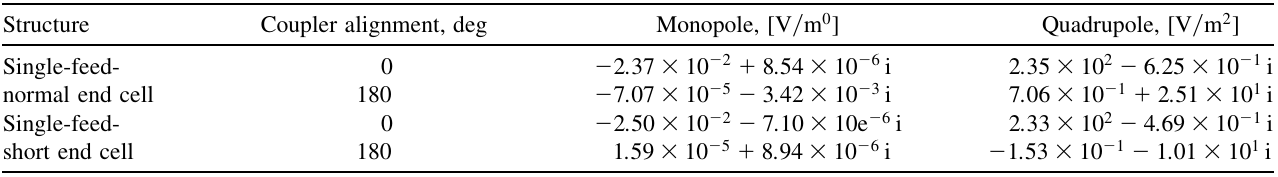
TABLE I. Monopole and quadrupole components for CLIC crab cavity structures discussed. All values correspond to PEC walls ¼ 1 V . and V crab